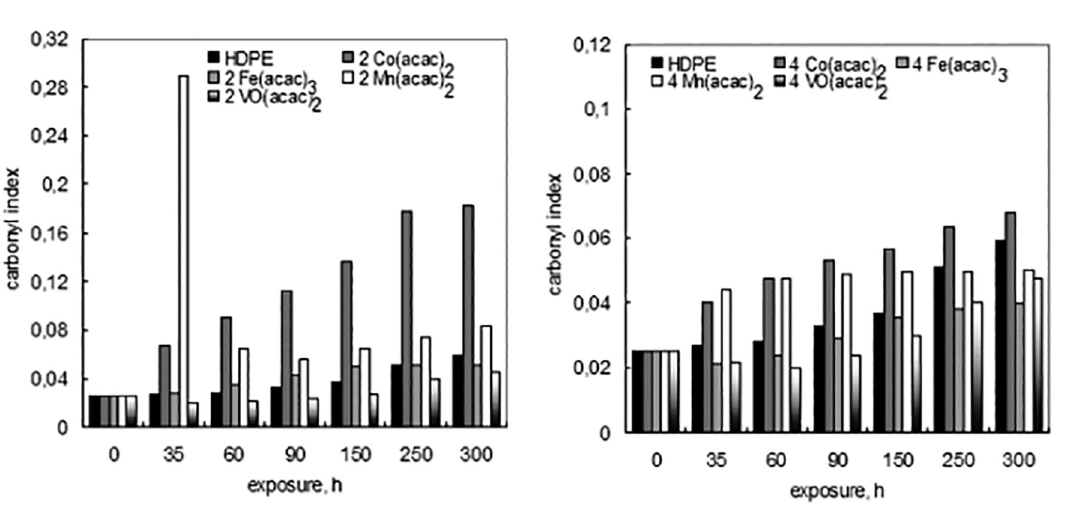
Figure 2: Dependence of the carbonyl index of foils of initial irradiated HDPE and irradiated foils containing pro-oxidants at different exposure